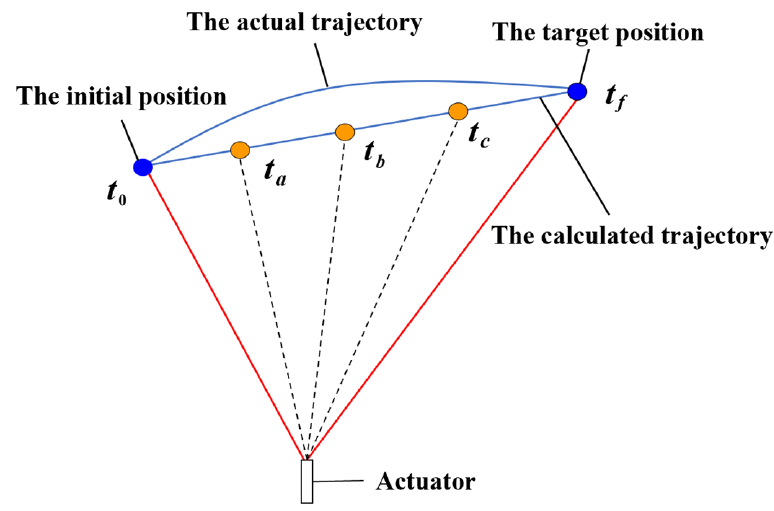
Figure 4. Schematic diagram of path elements.